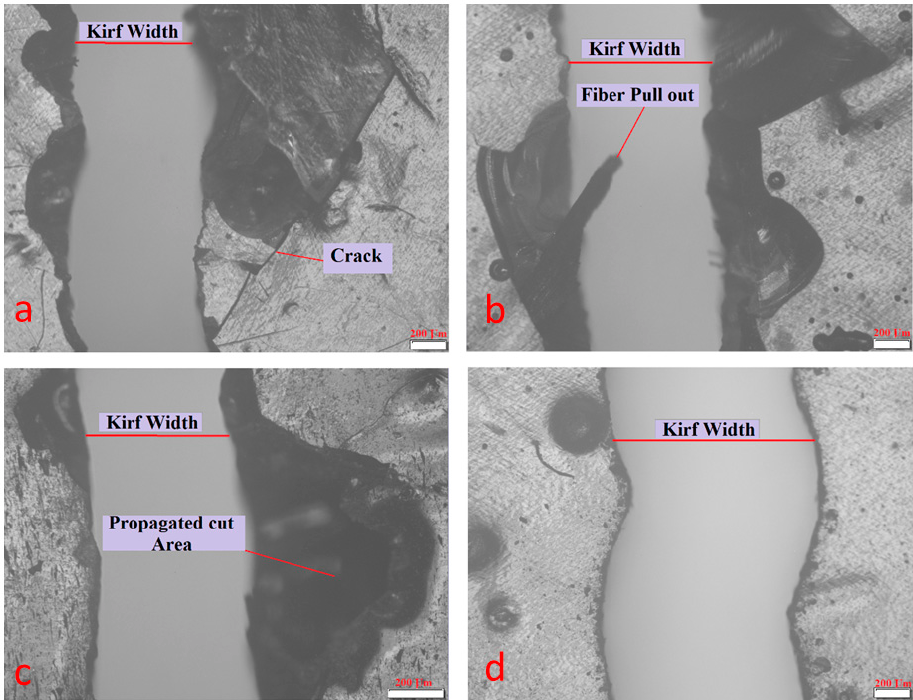
Figure 7. ( a ) Damages and cracks at cutting kerf. ( b ) Incomplete cut and pull out of fibers. ( c ) High propagated cutting area. ( d ) Uneven